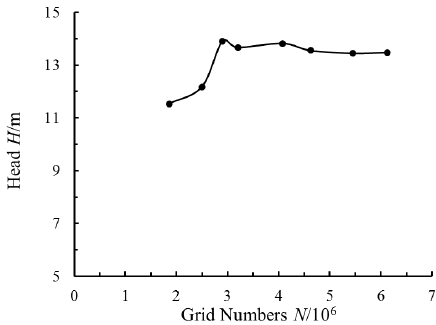
Appl. Sci. 2019 , 9 , x FOR PEER REVIEW Figure 4. Analysis of mesh independence.